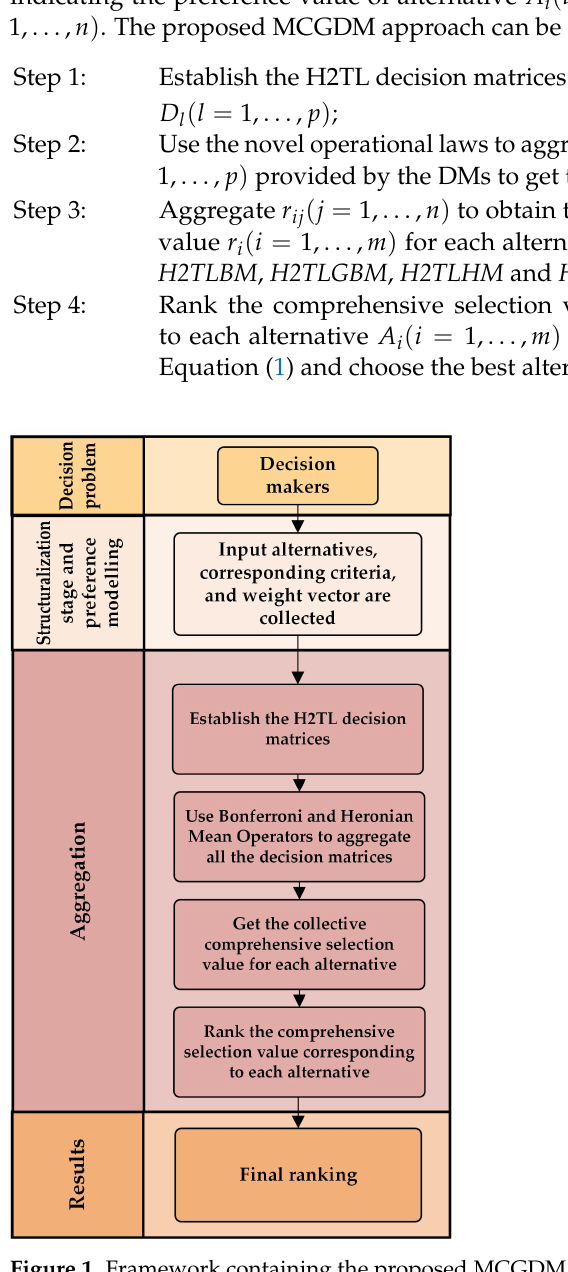
Figure 1. Framework containing the proposed MCGDM approach with H2TL